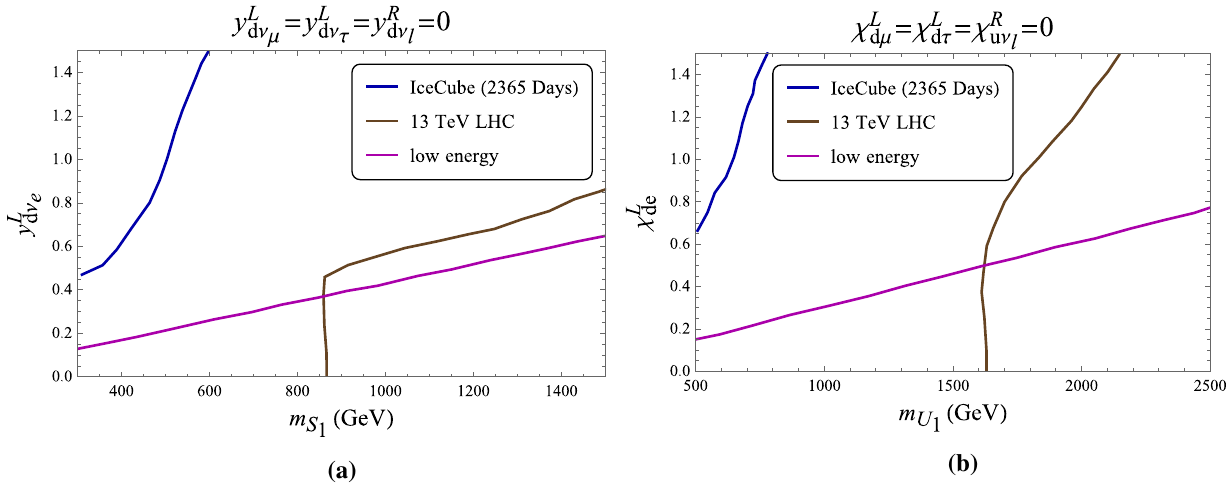
Fig. 7 Thetotaleventrate,withtheLQcontributionfor m U = y L = 0) (right panel). The gray shaded region and the bin with zero events are not included in the fit y L d ν μ d ν τ